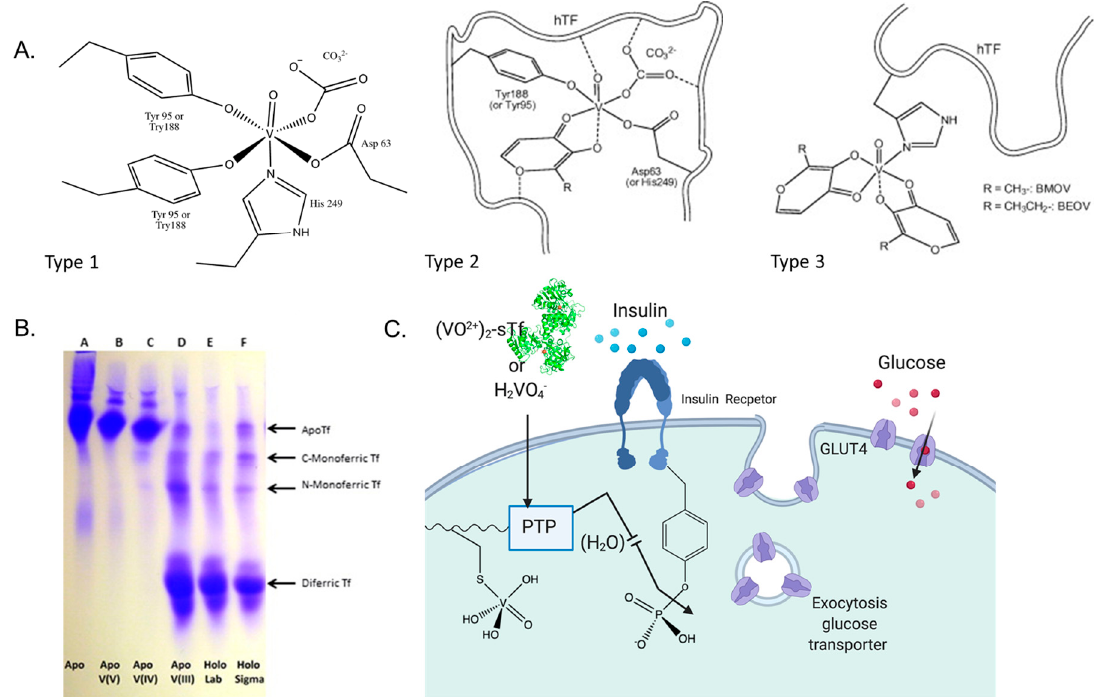
Figure 15. Vanadium interaction with sTf. ( A ). Three proposed types of VO 2+ binding to sTf. Types 1 and 2 involve direct coordination to the metal binding site with and without a carrier ligand as a synergistic anion. Type 3 shows the VOL 2 complexes binding adventitiously to a surface site of Fe 2 -sTf. ( B ). Urea-PAGE of sTf with and without V(III), V(IV), V(V), and Fe(III). Note that V(IV) should run through the gel like V(III) but the presence of EDTA in the running buffer resulted in V(IV) dissociation. ( C ). Proposed route for VO 2+ and V(V) entry into cells and the insulin-enhancing mechanism of [VO(OH) 3 ] − inhibition of the PTP enzymes. ( A ) and ( B ) were partially adapted with permission from [67]. Copyright (2014) Elsevier. ( C ) was created with BioRender.com.